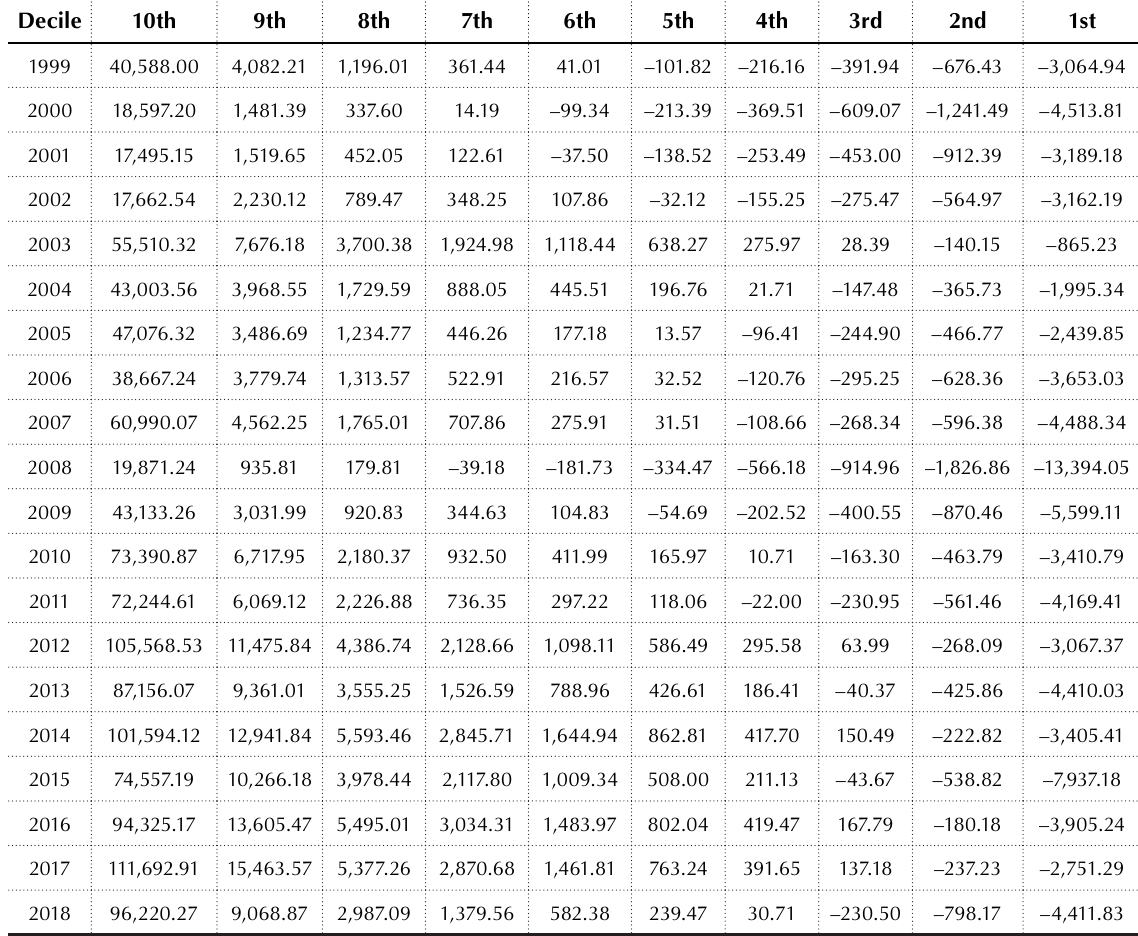
Table 1. Average MVA of MVA ranking portfolios (million Baht) Decile